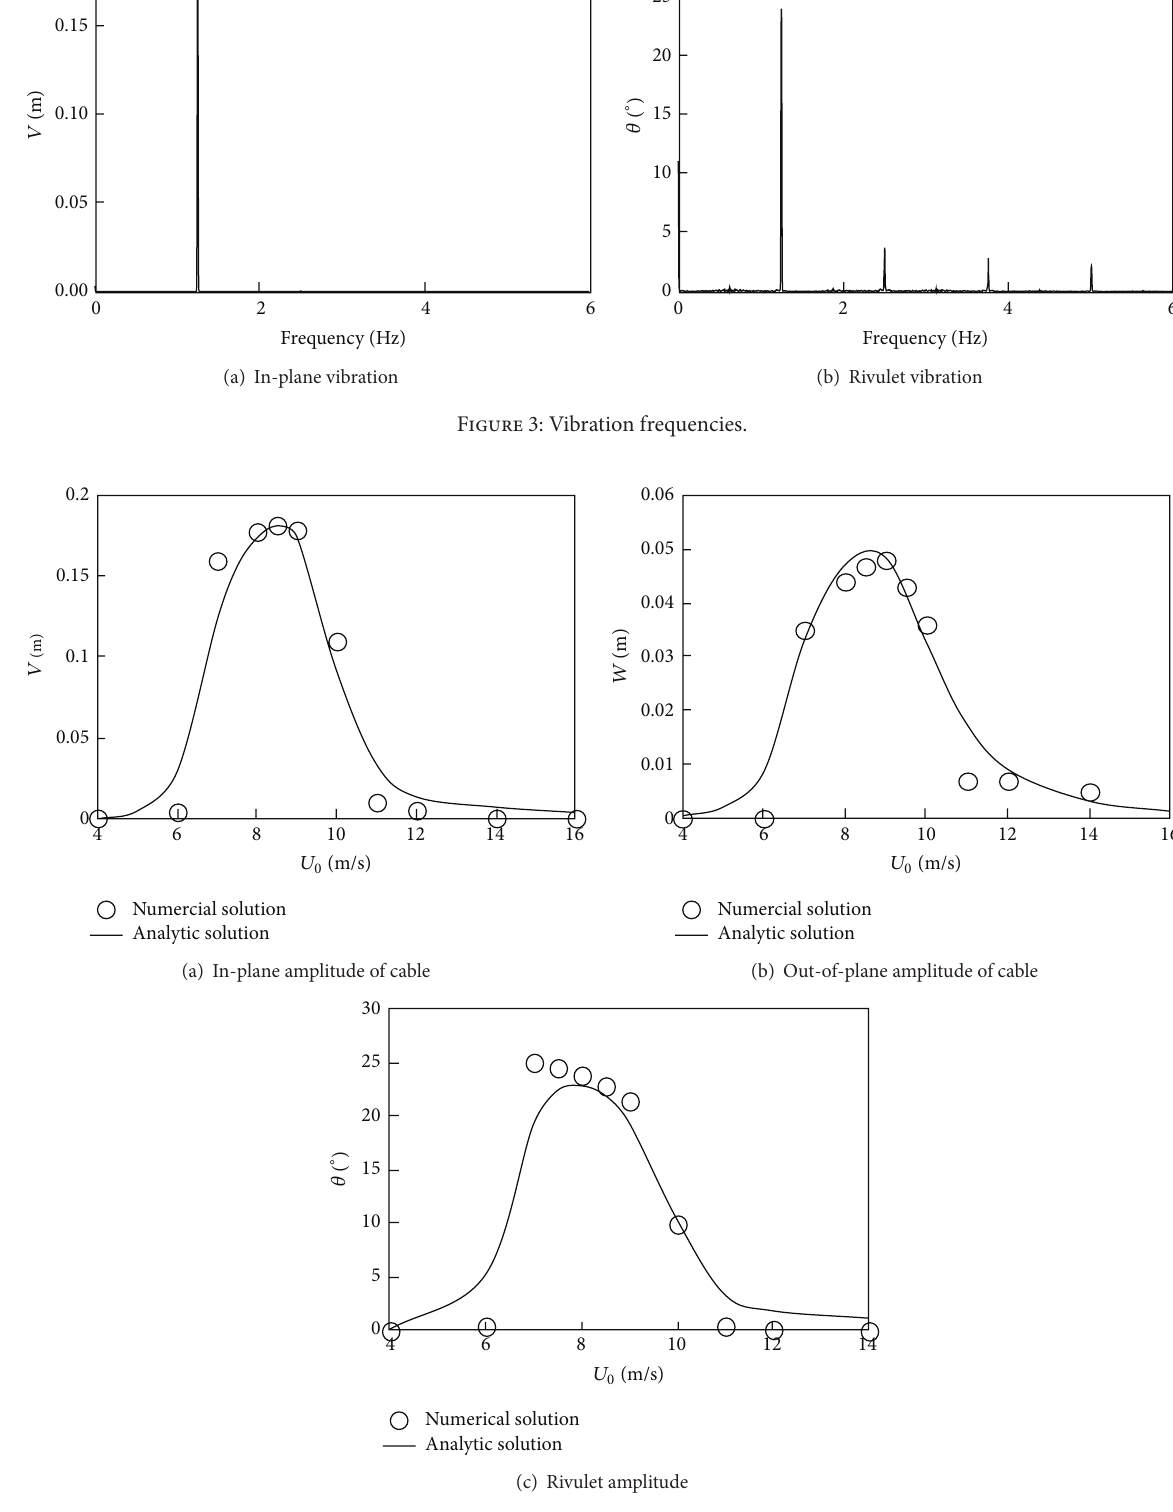
Figure 4: Comparison diagram of analytic and numerical